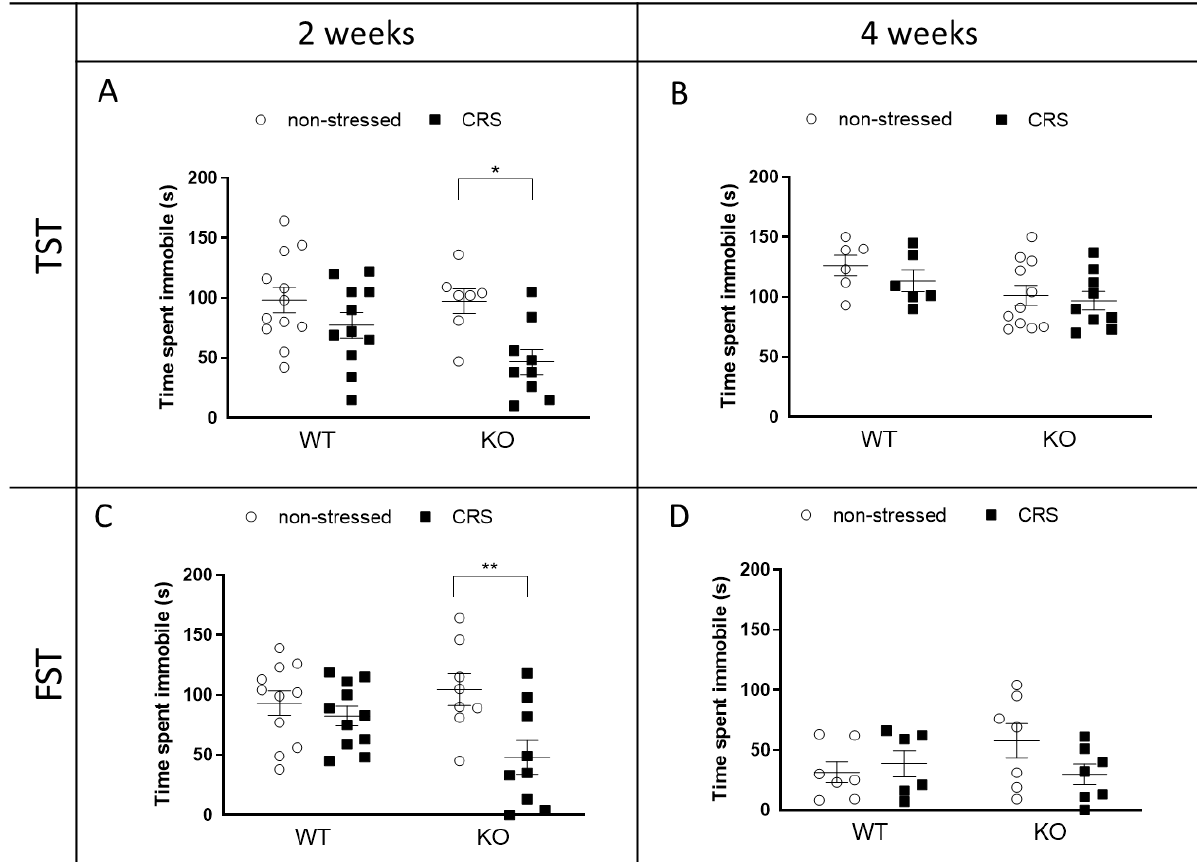
Figure 4. Effects of chronic restraint stress (CRS) on depression-like behavior in wild-type (WT) and Interleukine-1 knock-out (KO) female animals. Tail suspension test (TST) shows time spent immobile after 2 weeks ( A ) and 4 weeks ( B ) of restraint. Immobility time shown in the forced swim test (FST) after 2 weeks ( C ) and after 4 weeks ( D ) of CRS. Data are presented as the means ± SEM of n = 6–12 animals with individual plots; two-way analysis of variance (ANOVA), followed by Tukey’s tests; * p < 0.05, ** p < 0.01 vs. own control